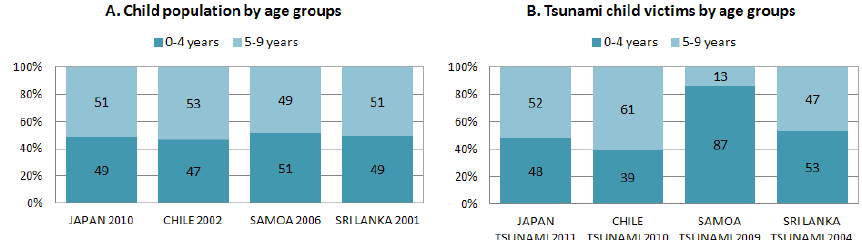
Figure 4. Analysis of child age groups (tsunami events of Japan 2011, Chile 2010, Samoa 2009 and Sri Lanka 2004) according to (a) pre- tsunami census data and (b) data on tsunami victims.